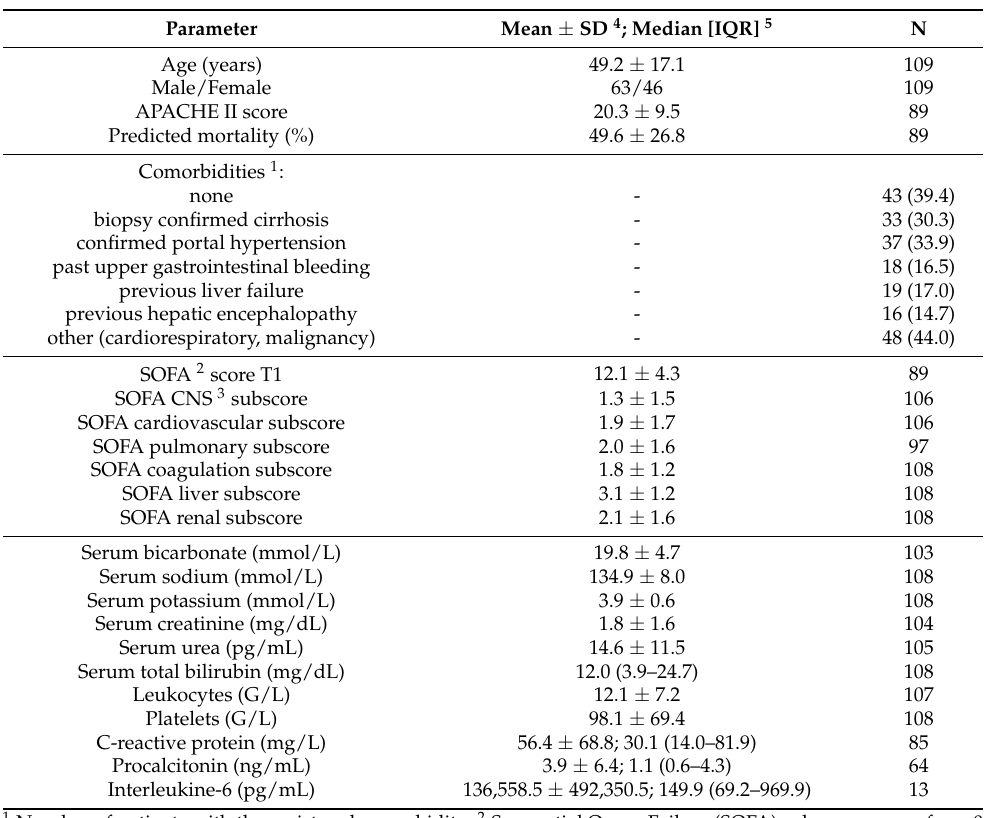
Table 1. Demographics, baseline